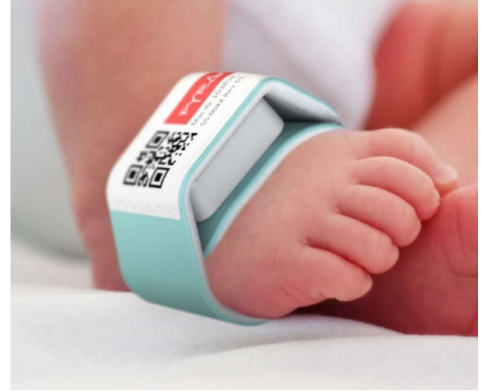
Figure 1. Boppli TM device to monitor the blood pressure of infants in critical